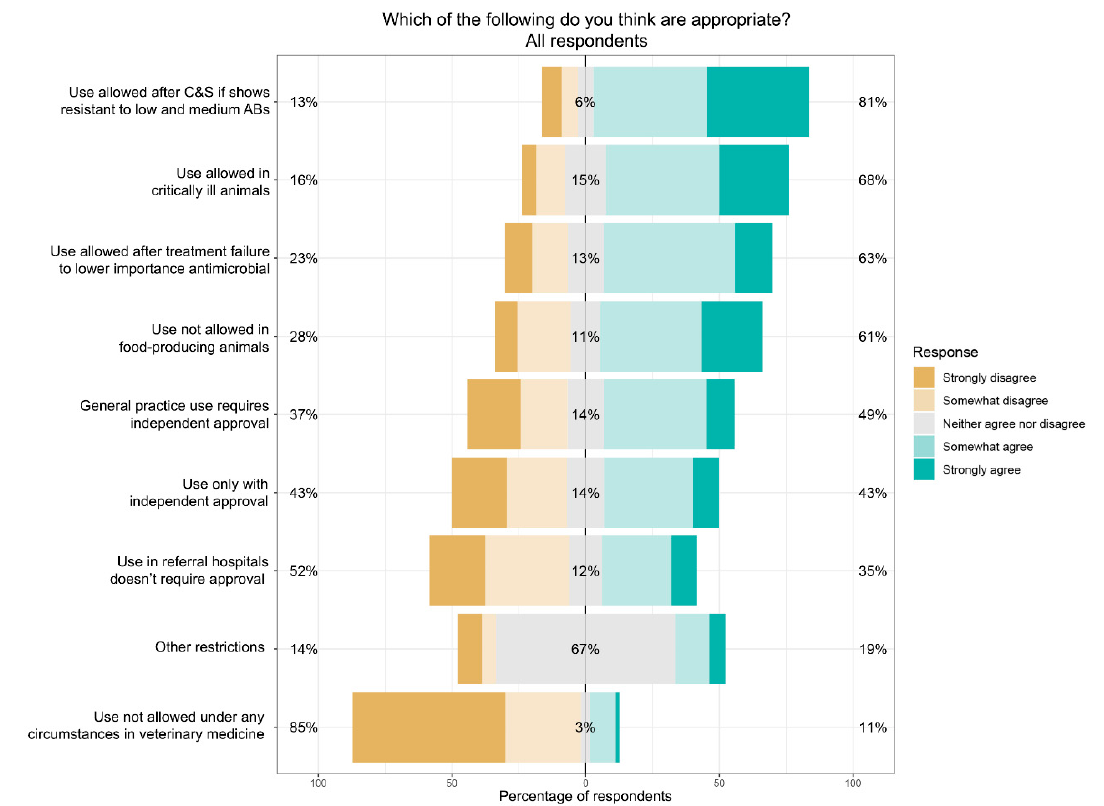
Figure 2. Responses of all participants to the question: “If there were to be restrictions placed on veterinary prescribing of antimicrobials with a high importance rating, which of the following do you think is appropriate?”.